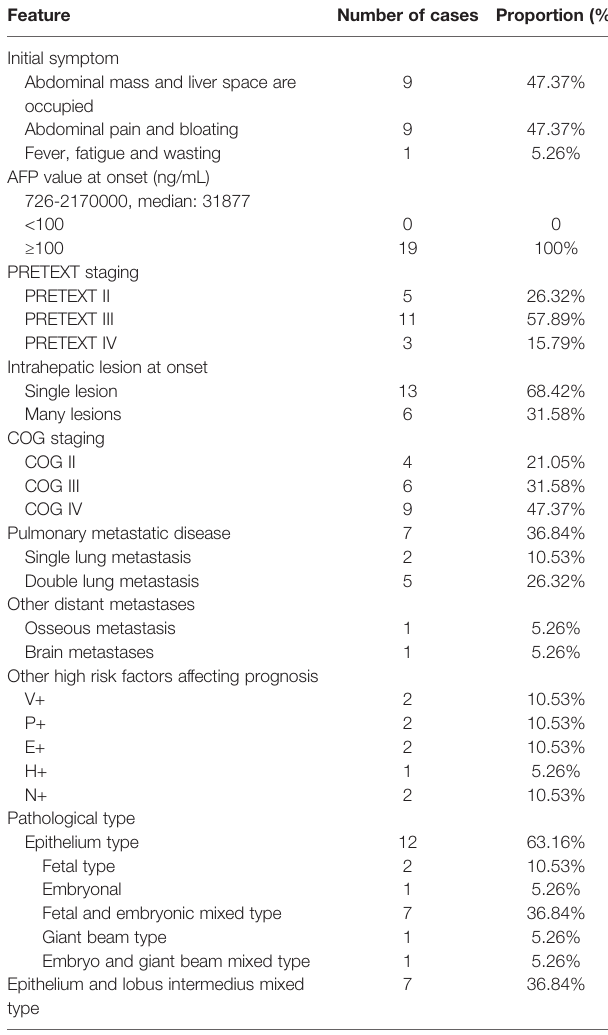
TABLE 1 | Clinical features of 19 pediatric patients with